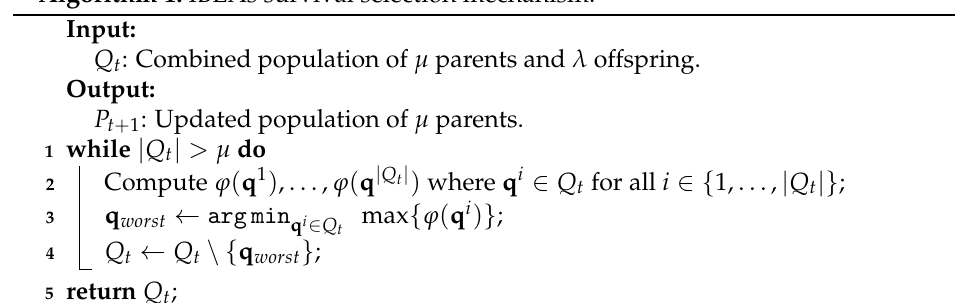
Algorithm 1: IBEAs survival selection